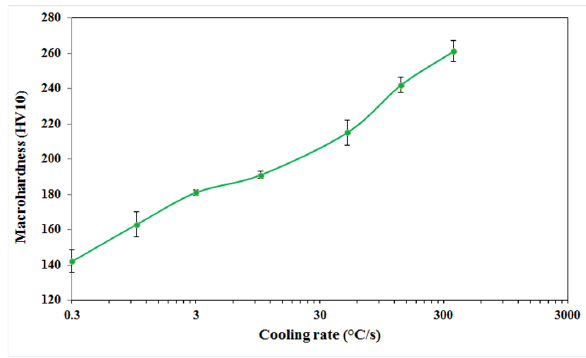
Figure 3: The macrohardness results of various weld simulated API 5L X-60 pipeline steel samples at different cooling rates. For information and better comparison, the macrohardness of raw API 5L X-60 steel samples in normalized condition is